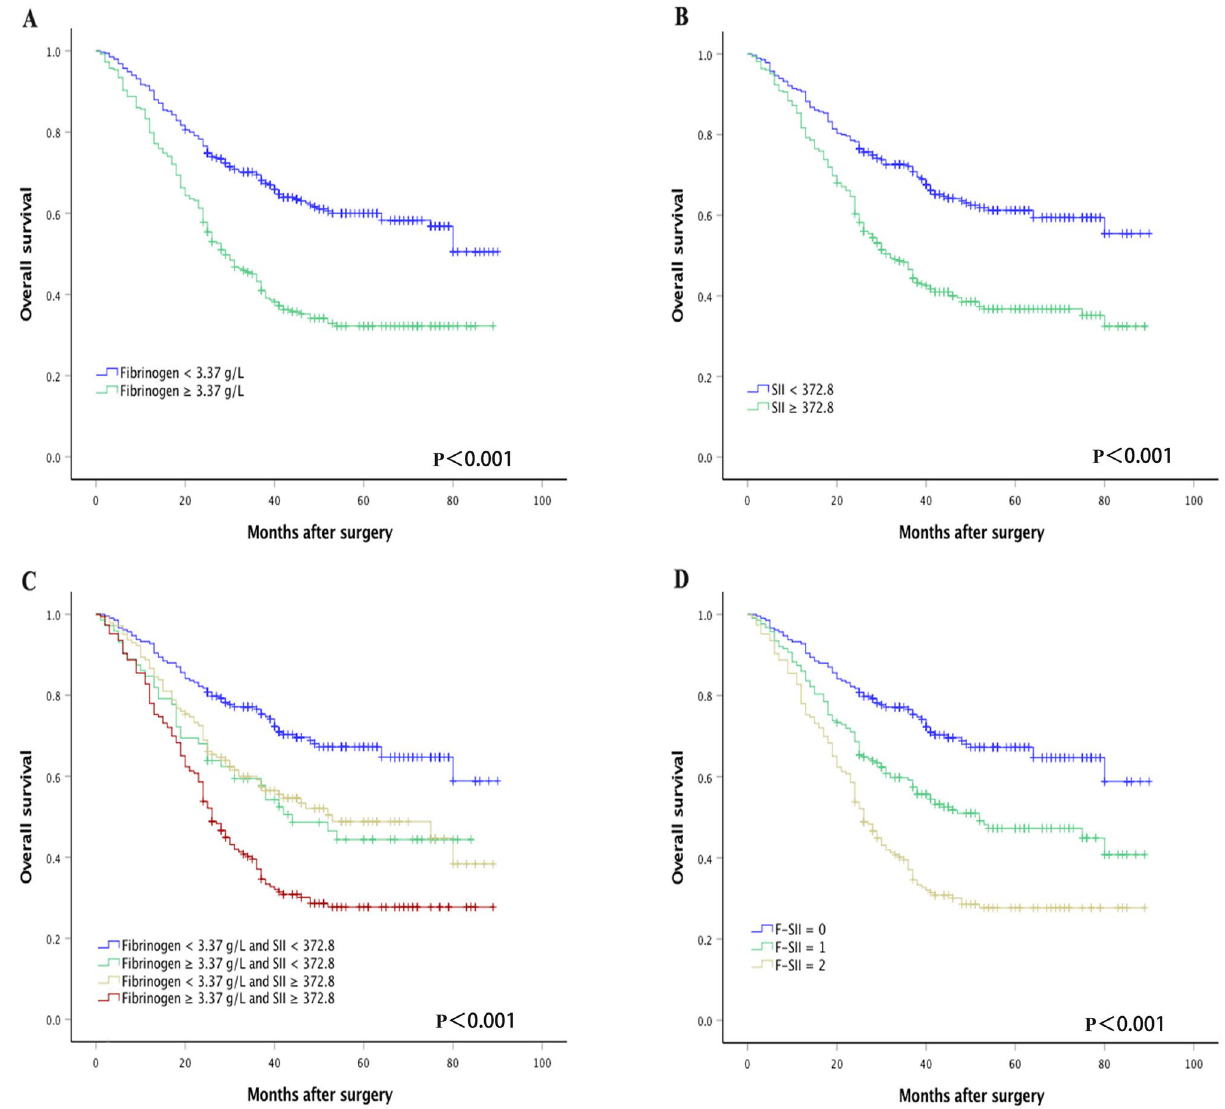
Figure 1. Kaplan–Meier analysis for OS of GC patients according to preoperative plasma fibrinogen level and the systemic immune-inflammation index (SII). Kaplan–Meier analysis for OS according to ( A ) preoperative plasma fibrinogen level, ( B ) preoperative SII, ( C ) combination of preoperative plasma fibrinogen and SII, and ( D ) F-SII